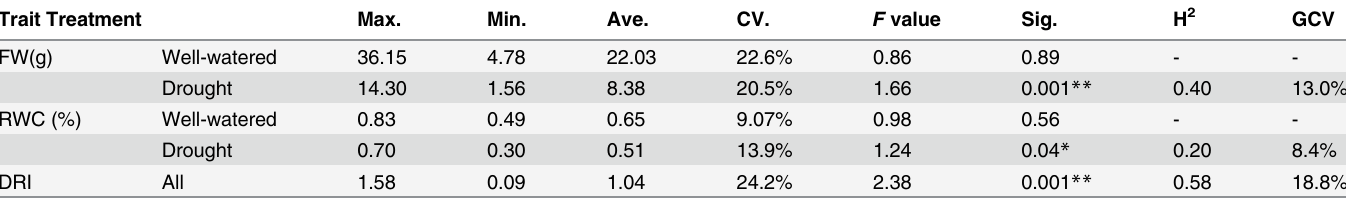
Table 2. Statistical analyses for phenotyping fresh weight (FW), relative water content (RWC) and drought resistance index (DRI) in 198 alfalfa accessions. Trait